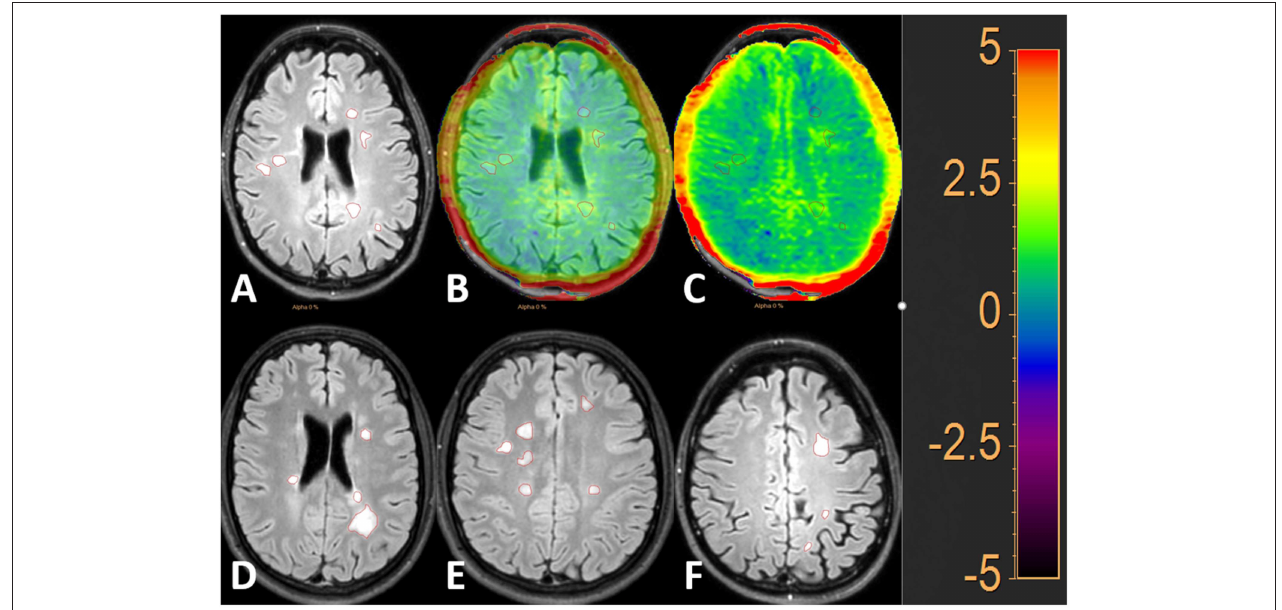
FIGURE 2 | FLAIR image with 50% and 100% APTw image overlay. MS lesions (MSL) are outlined in red. The image to the left shows the lesions on FLAIR (A) , the middle image shows the FLAIR image with 50% APTw overlay (B) and the image to the right shows the FLAIR image with 100% APTw overlay (C) . Additional examples of the lesion selection are given in (D–F) .